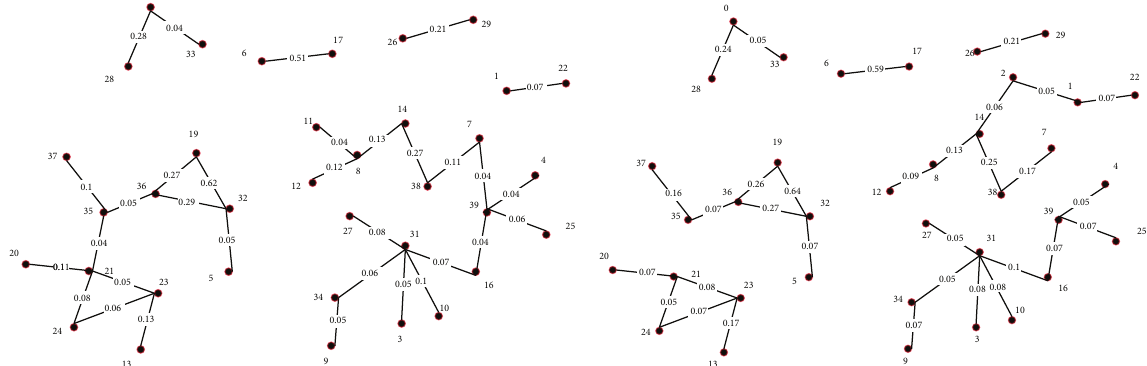
Figure 9: Comparisons between Infocom 05 trace and IHC: meaningful social